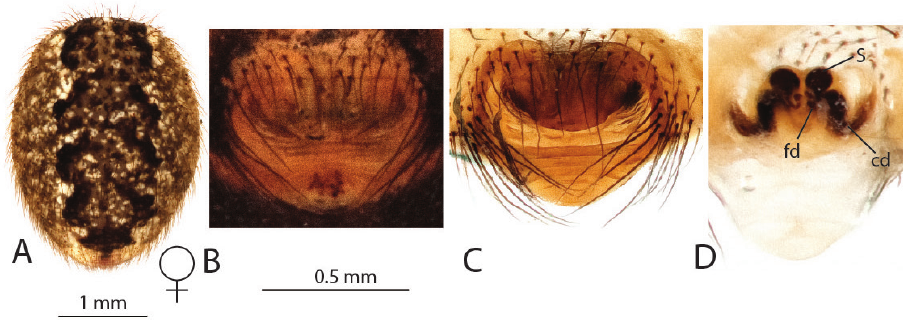
Figure 15. Anelosimus buffoni : A female abdomen dorsal B epigynum ventral view C epigynum cleared ventral D epigynum cleared